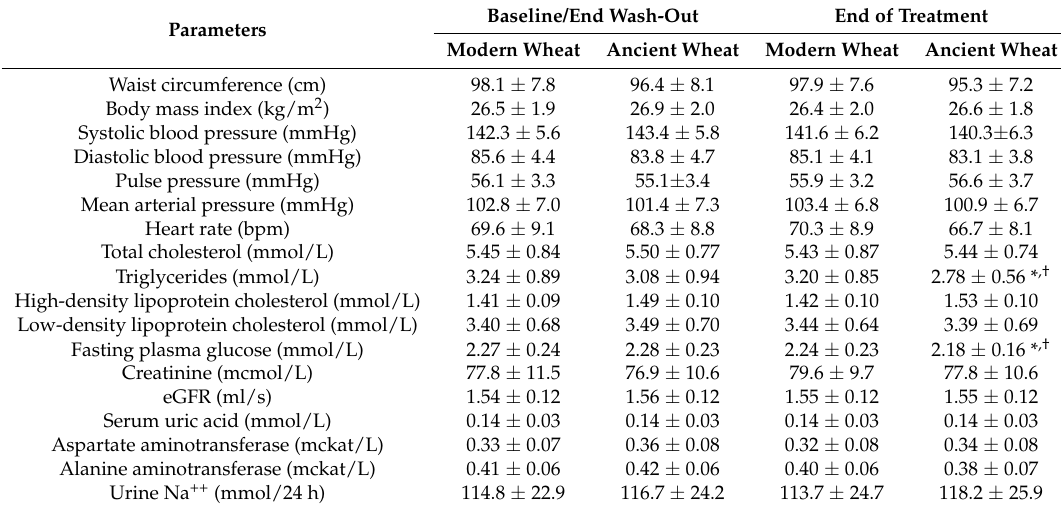
Table 5. Changes in anthropometric, hemodynamic, and hematochemistry data from baseline/end wash-out to end of treatment, expressed as mean ± standard